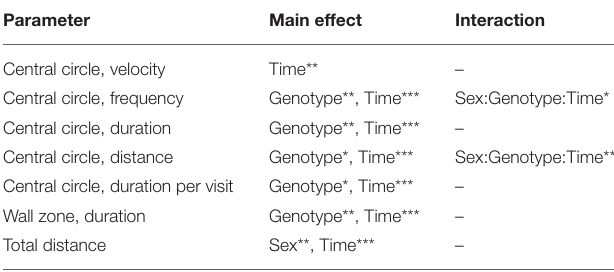
TABLE 1 | Statistical main effects and interactions of genotype, time and sex in the open field (OF) test.